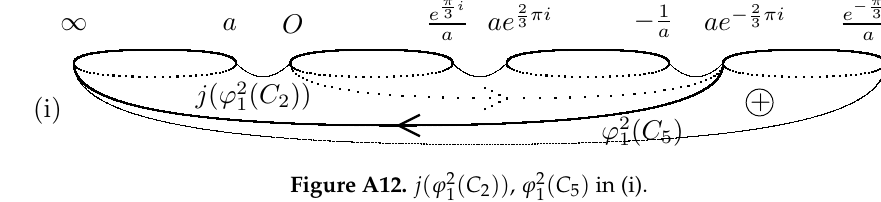
Figure A12. j ( ϕ 2